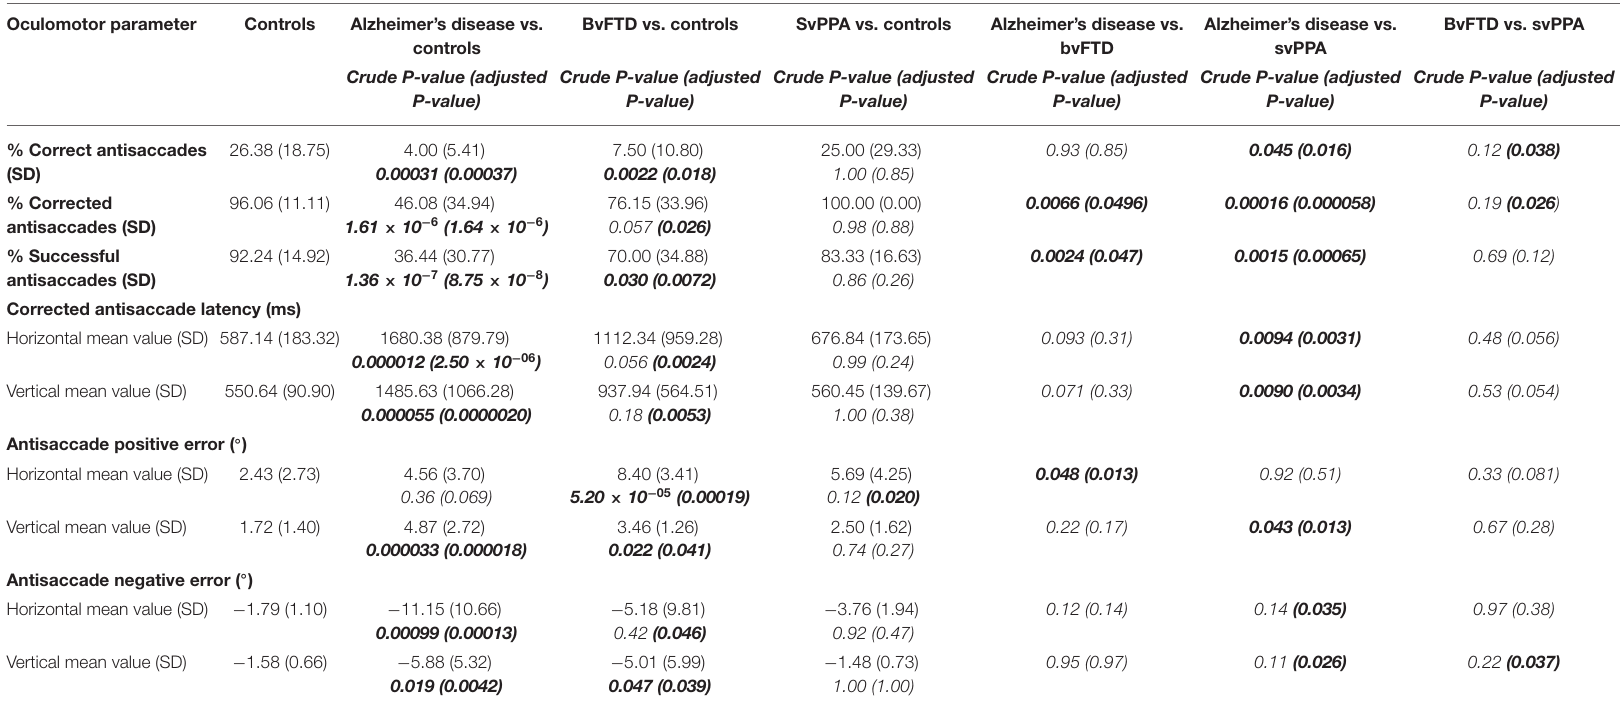
TABLE 3 | Volitional saccades: Antisaccade